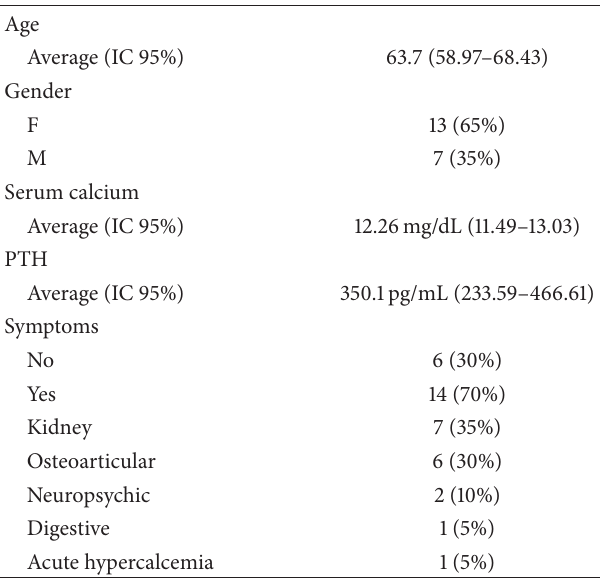
Table 1: Patients with